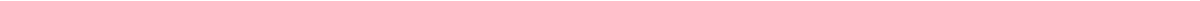
Fig. 7 AIM1 and actin localization in normal prostate, prostate adenocarcinoma and prostate embryonic development. a Co-immunolabeling of AIM1 ( red ) and β -actin ( green ) reveals high degree of co-localization in normal prostate epithelium. In prostate cancer, this co-localization is largely abolished and AIM1 shows a diffuse cytoplasmic staining pattern. Nuclei are counterstained with DAPI. b Boxplot shows distribution of co-localization coef fi cients of AIM1 and β -actin immunostaining in prostate cancer and adjacent benign prostate epithelium ( n = 8 cases). Scale bars indicate 50 μ m. c Proximity ligation assays (PLA) con fi rm close spatial proximity of AIM1 and β -actin in benign prostate epithelial cells and greatly reduced interaction in invasive carcinoma. Red dots indicate discrete interaction signals by PLA; green shows β -actin immunostaining. Scale bars indicate 100 μ m. d Boxplot shows differences in area- normalized PLA signals in benign glands and invasive carcinoma ( n = 8 cases). e Immunolabeling for Aim1 (shown in red ) and β -actin (shown in green ) in urogenital mesenchyme (UGM) and urogenital sinus epithelium (UGE) from mouse embryos at day 17.5 post conception. Note the UGE-speci fi c expression of Aim1, with membranous staining and actin co-localization in bulk UGE ( arrowheads ), and more diffuse cytoplasmic staining in UGE-derived prostatic buds (labeled B) invading into the surrounding UGM ( arrows ). Scale bars indicate 100 μ m. f Boxplot shows distribution of co-localization coef fi cients of Aim1 and β -actin immunostaining in UGE close to the urogenital sinus (Bulk UGE) and invading prostatic buds (Bud) ( n = 4). g IHC con fi rms membranous staining pattern of Aim1 in bulk UGE and decreased, diffuse Aim1 immunoreactivity in invading buds. h PLA demonstrates spatial proximity of Aim1 and β -actin UGE close to the urogenital sinus and decreased PLA signals in invading prostate buds. Scale bars indicate 100 μ m. i Boxplot shows differences in area-normalized PLA signals in bulk UGE and invading buds ( n = 3). All P values are derived using t -test